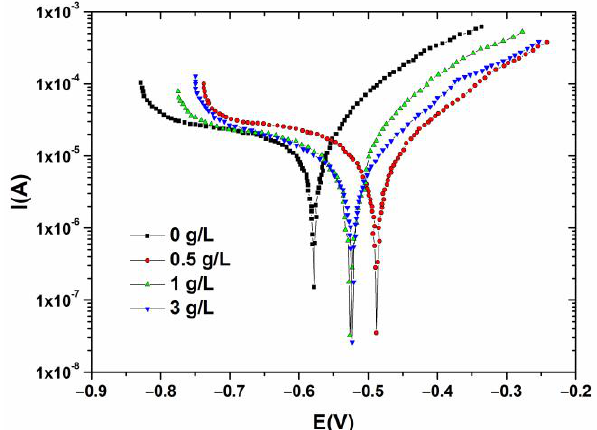
Figure 4. Bode modulus of the Ni-W alloy and Ni-W/B composite coatings with varying boron concentrations (0, 0.5, 1, and 3 g/L). concentrations (0, 0.5, 1, and 3 g/L).